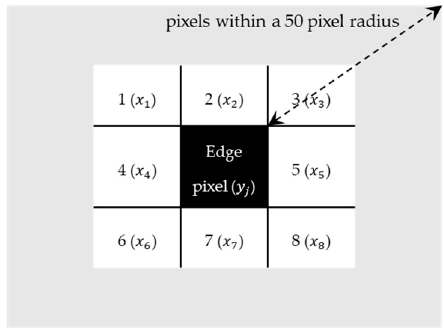
Figure 3. An example of an edge pixel and its eight neighbors in an image.